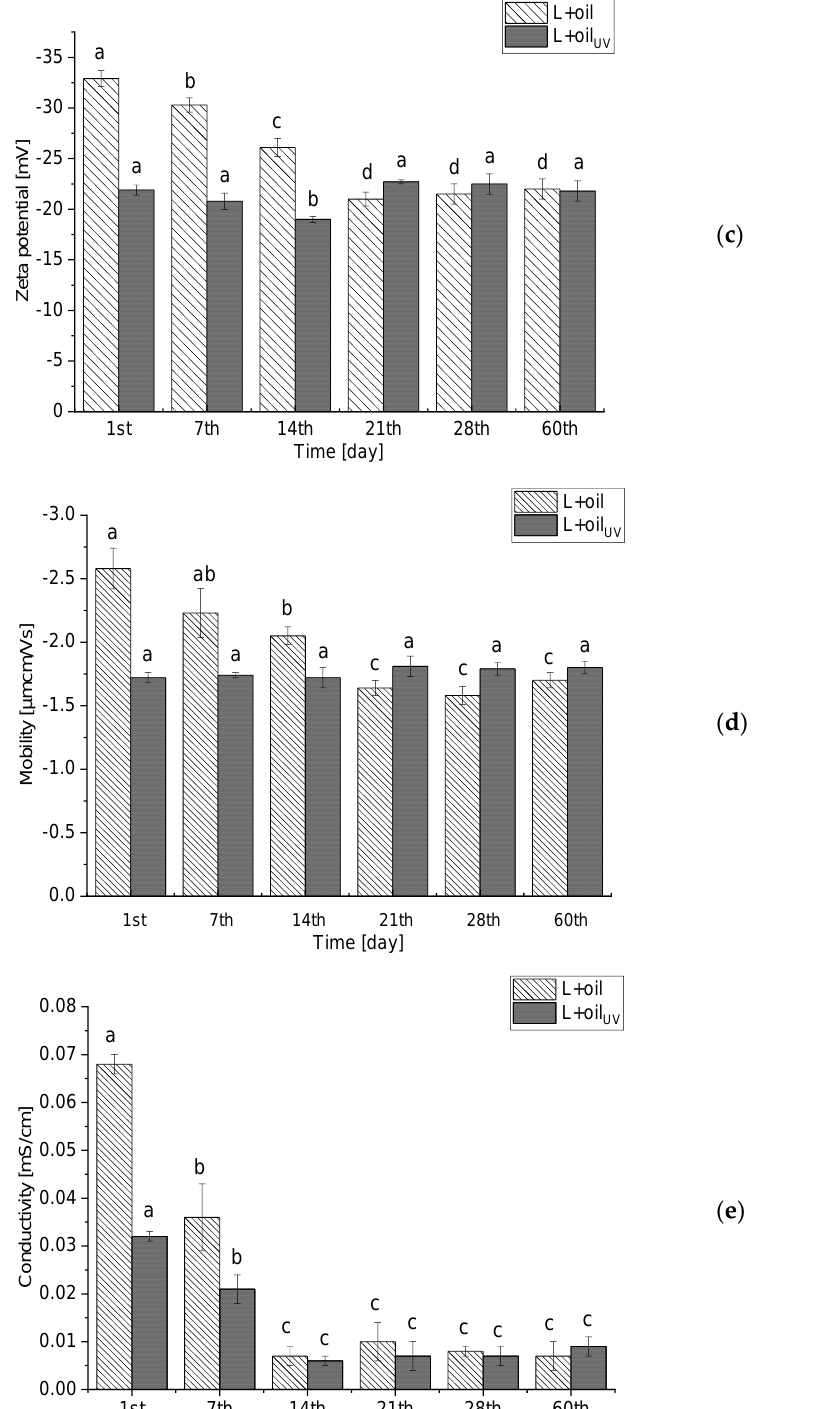
Figure 1. Liposome size ( a ), polydispersity index ( b ), zeta potential ( c ), mobility ( d ), and conductivity ( e ) of the non-treated and UV-irradiated Rosa canina seed oil-loaded liposomes during 60 days storage at 4 ◦ C; values with different letters ( a – d ) in each row showed statistically significant differences ( p < 0.05; n = 3; analysis of variance, Duncan’s post-hoc test); L, liposomes. The size of the liposomal population with the rosehip oil did not change significantly during 14 days of storage at 4 ◦ C, but after the 21st day, the vesicle size rose from 952.8 ± 20.1 nm to 1157.7 ± 25.8 nm and amounted to 1179.2 ± 21.4 nm at the 60th day, whereas